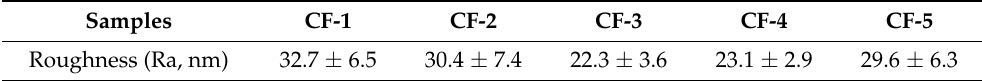
Figure 3. The SEM cross-section morphology image of: ( a1 ) CF-1, ( b1 ) CF-2, ( c1 ) CF-3, ( d1 ) CF-4, ( e1 ) CF-5; and the AFM surface morphology image of: ( a2 ) CF-1, ( b2 ) CF-2, ( c2 ) CF-3, ( d2 ) CF-4, ( e2 ) CF-5. Table 1. The surface roughness of 5 types of CFs.